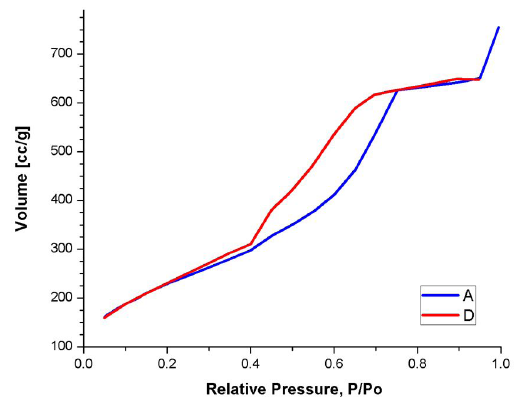
Figure 4. Nitrogen adsorption‑desorption isotherms of SBA‑15 mesoporous ceramic